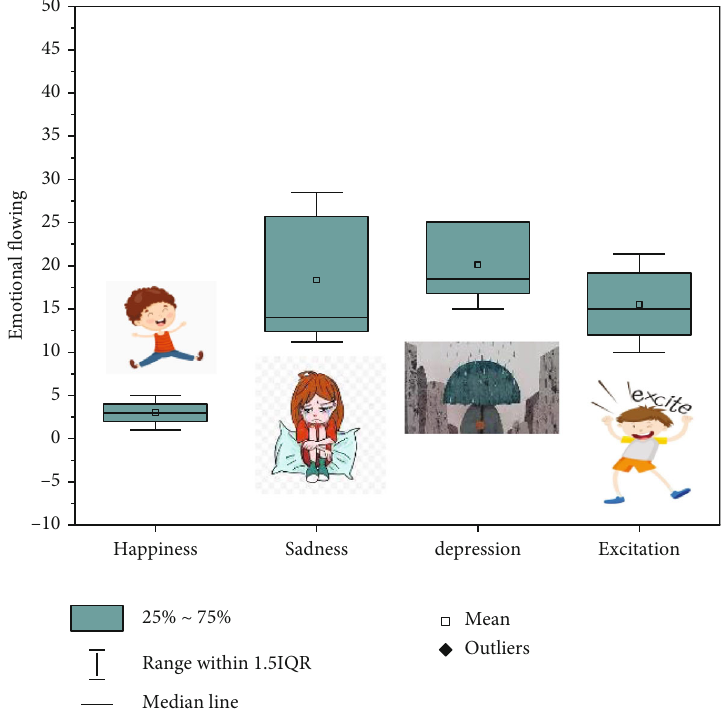
Figure 6: Melody and emotion of the theme song.